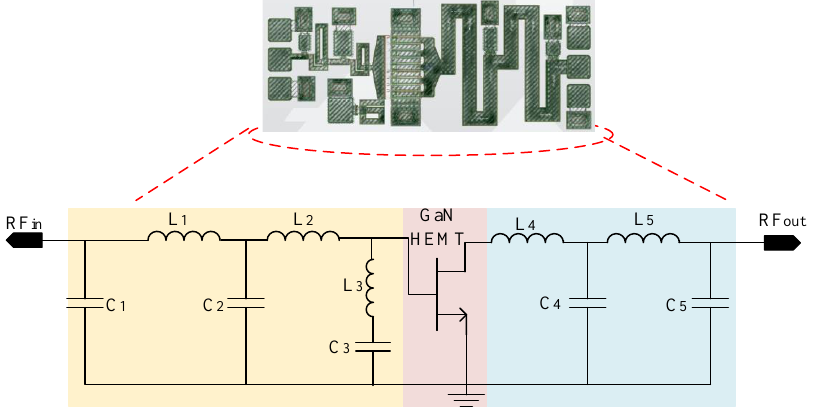
Figure 6. MMIC design and optimization through DNN. Table 3. Design parameters of optimized MMIC, class-AB amplifier, in Figure 6; The unit of each inductor and capacitor are nH and pF, respectively